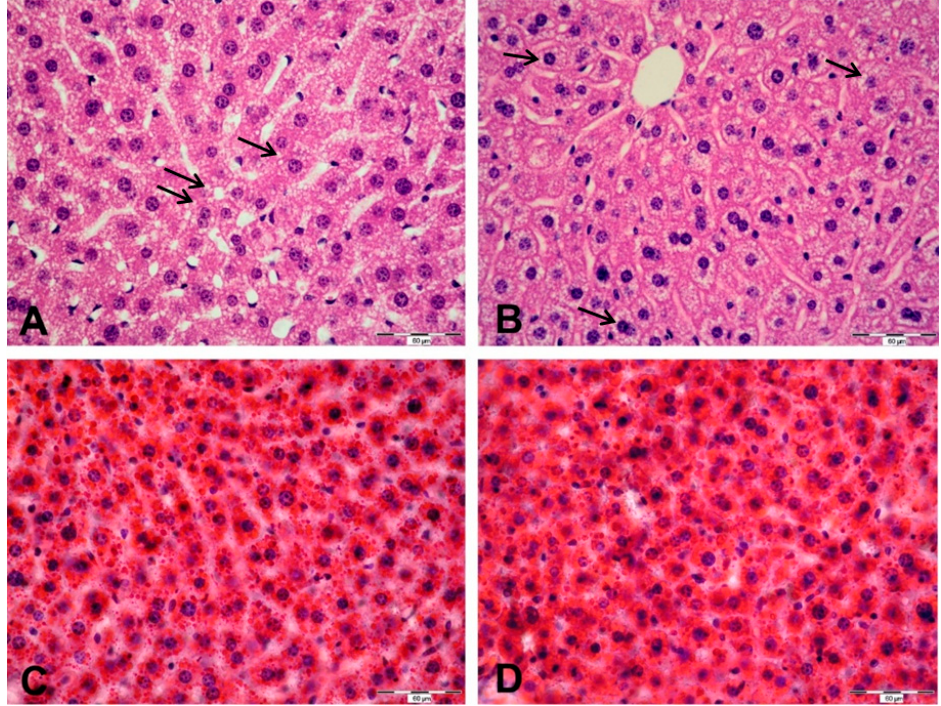
Figure 7. Liver tissue of wild type ( A , C ) and T ff 3 knock-out ( B , D ) tunicamycin-treated mice stained using hematoxylin-eosin ( A , B ) and oil red O ( C , D ). Numerous small lipid droplets (marked with black → ) are visible in the cytoplasm of hepatocytes stained using hematoxylin-eosin. There is no apparent morphological di ff erence in fatty changes between the two groups. On oil red O-stained slides, lipid droplets stained intensively red are abundant in hepatocyte cytoplasm across the slide. There is no apparent morphological di ff erence in fatty changes between the two groups. Scale bar: 60 µ